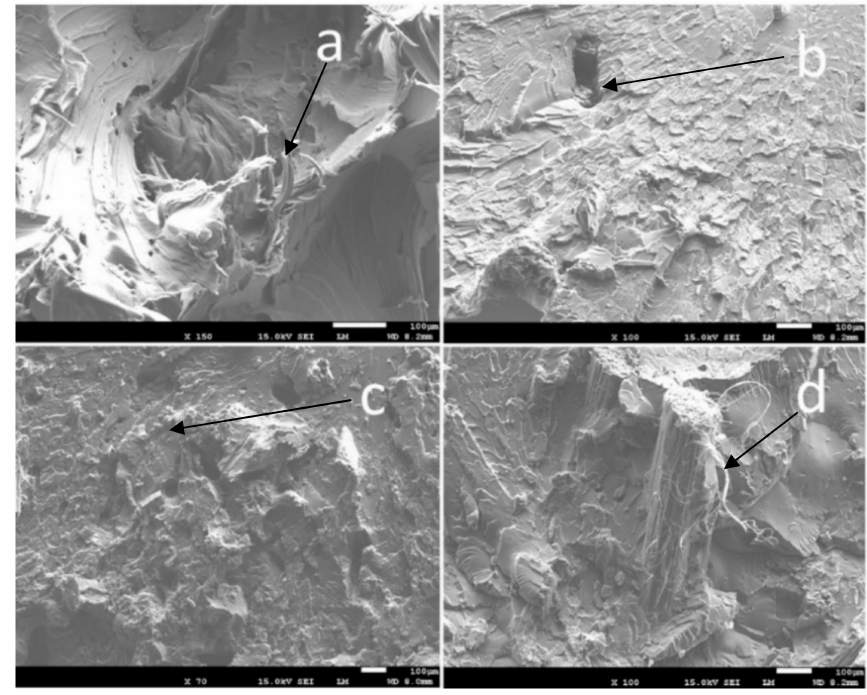
Figure 13. SEM of fracture surfaces: neat COPET11 ( a ), COPET11 + 5% BF ( b ), COPET2 + 10% BF ( c ), and COPET11 + 20% BF ( d